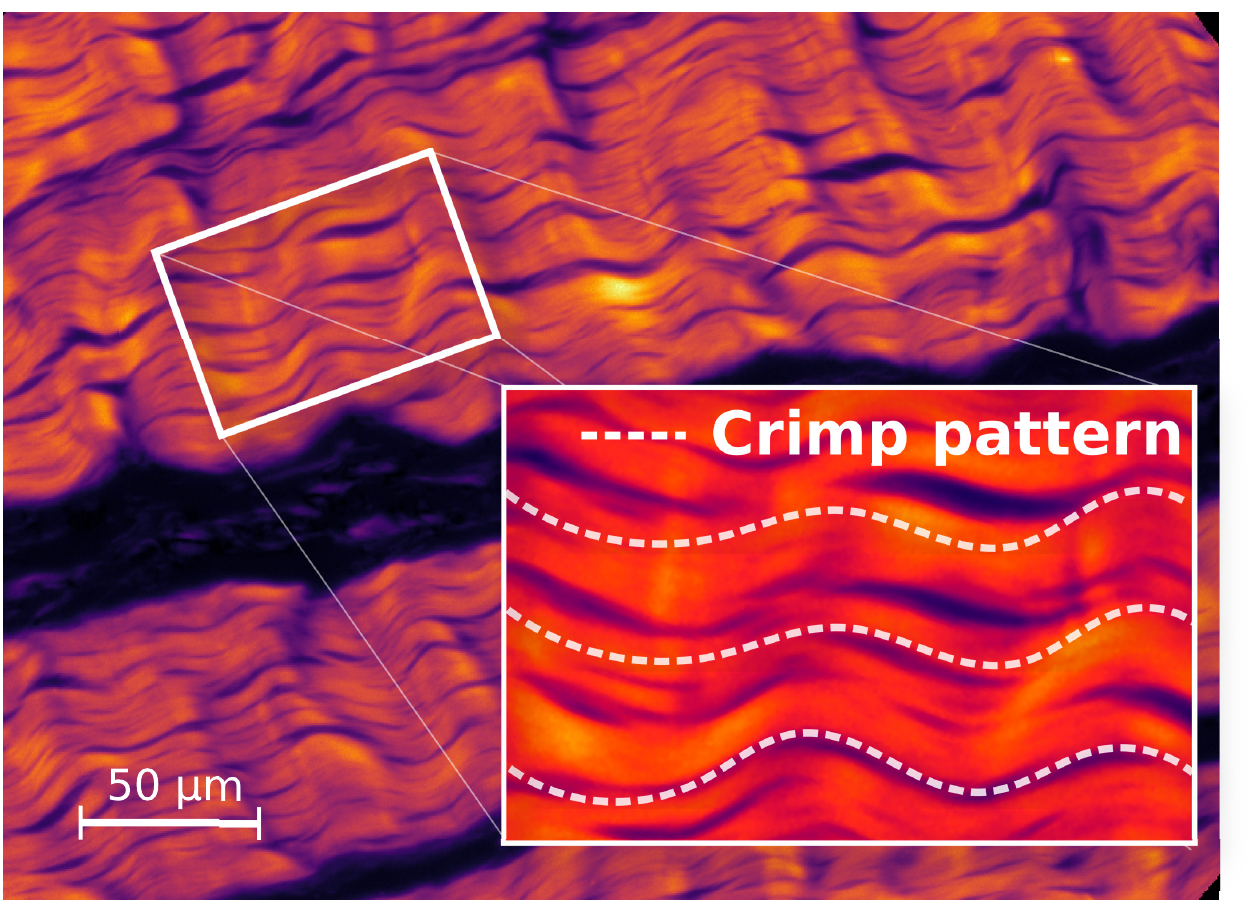
Fig 4. Polarized light microscopy. An example optical retardance image of ACL sample used to determine the crimp parameters. The values for crimp length and angle were calculated as an average from manually selected regions of interest.